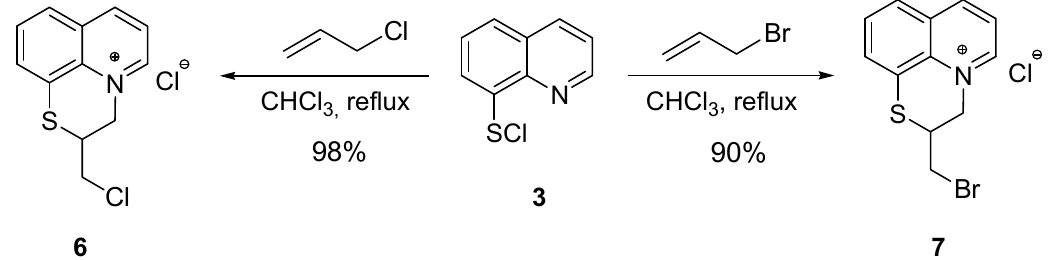
Scheme 4. Synthesis of 2-(chloromethyl)- and 2-(bromomethyl)-2 Н ,3 Н -[1,4]thiazino[2,3,4- ij ]quinolin-4-ium chlorides 6 and 7 from allylchloride, allylbromide and sulfenyl chloride 3 .